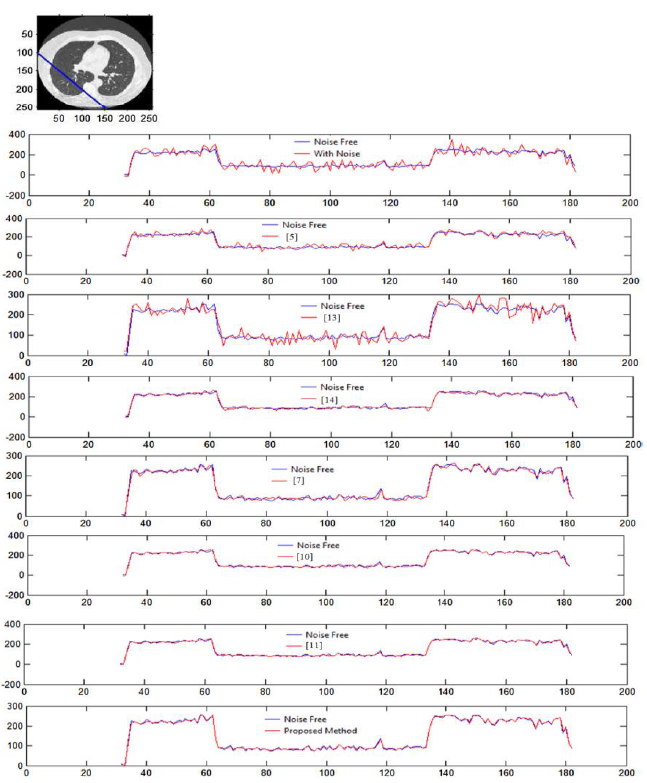
Figure 10. Intensity profiles of original image against existing methods and the proposed frame- work, respectively. Intensity profile of [5] is result of Medical image denoising by parallel non-local means; Intensity profile of [7] is result of customized nonlocal restoration schemes with adaptive strength of smoothening for magnetic resonance images; Intensity profile of [10] is result of Shearlet and guided filter based despeckling method; Intensity profile of [11] is result of Local activity-driven structural-preserving filtering; Intensity profile of [13] is result of multi-scale transform and non- local means filter; Intensity profile of [14] is result of multivariate model and its method noise